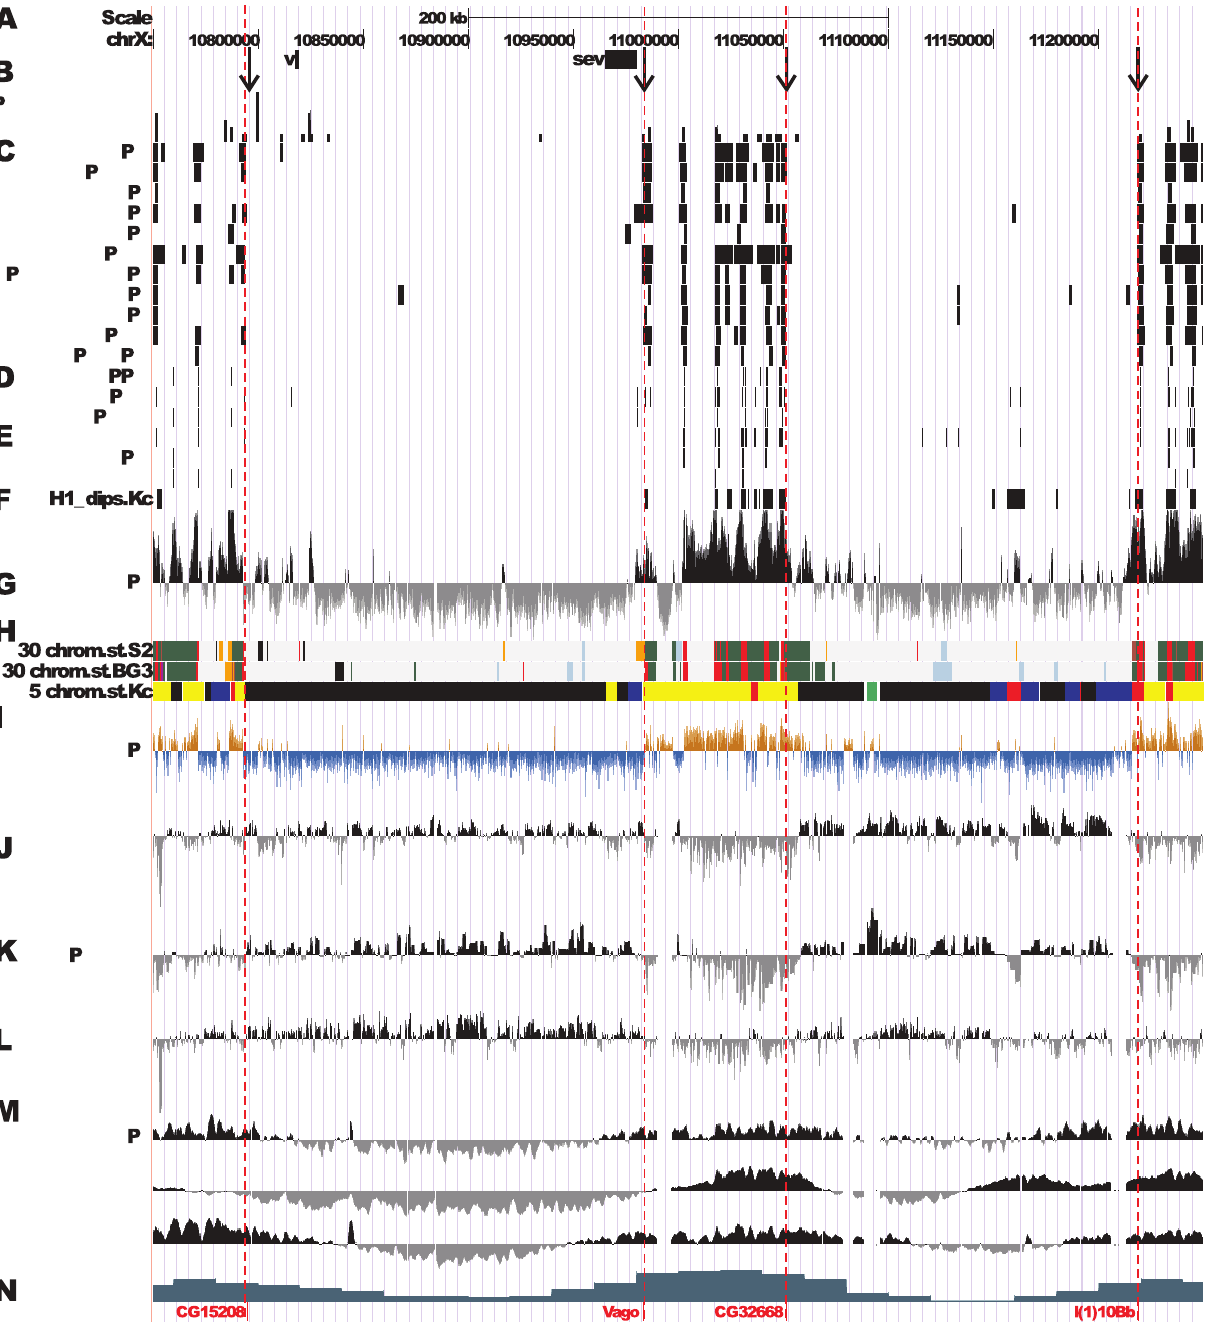
Figure 2. Localization of proteins and DNA elements in 9F13 – 10B3 region of nonpolytene chromosomes (according to data of modENCODE). The positions of proteins were located as described in Material and Methods. A - physical map of DNA; positions of v and sev genes are taken from FlyBase, arrows 1–4 indicate position of probes for FISH on physical map. B - P -elements density in the region calculated as number of insertions per 1 kb in 10 kb interval (data on insertions are taken from FlyBase) C - interband specific and active chromatin specific proteins in S2 cells [48], D - DNase I hypersensitivity sites (DHS) in S2, BG3 and Kc cells [48] E - ORC2-binding sites in S2, BG3 and Kc cultural and salivary gland cells [59] F - histone H1 dips localization in Kc cells [45] G - histone H3.3 localization in S2 cells (modENCODE, Henikoff group) H - 30 chromatin states in BG3 and S2 cells [48], and 5 chromatin types in Kc cells [47] I - nucleosome turnover dynamics in S2 cells [60], J - D1 localization in Kc cells [47], K - SUUR localization in Kc cells [47], L - Lamin localization in Kc cells [47] M - early (up) and late (down) replication in S2, Kc and BG3 cells [61] N - gene density (number of genes per 10 kb of DNA) [54]. doi:10.1371/journal.pone.0025960.g002 Chriz/CHRO proteins correspond to interbands of polytene types. Thus, we can map all the interband borders in a given chromosomes. This, in turn, indicates that Chriz/CHRO is region of a physical map, using the localization borders of various invariably bound to interbands in chromosomes of various cell interband-specific proteins (Fig. 2C, D, E, F, G).